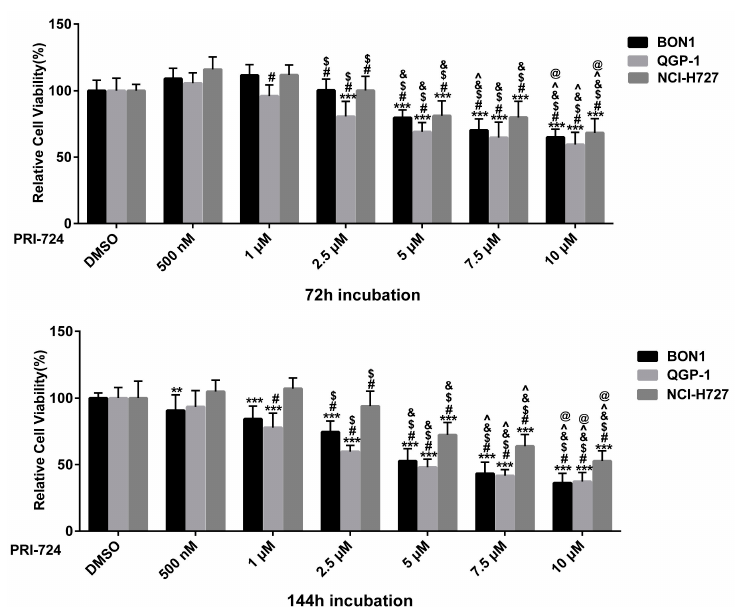
Figure 6. Effect of PRI-724 on the reduction of NET cell viability in a dose- and time-dependent manner. The cell viability of human pancreatic BON1 and QGP-1and bronchial NCI-H727 NET cell lines was assessed after treatment with PRI-724 compared with that of DMSO control. The data are expressed as mean ± SD. Each experiment, with technical triplicates, was repeated at least thrice. * p < 0.05, ** p < 0.01, and *** p < 0.001 compared with that of DMSO controls. # p < 0.05(1 µM–10 µM vs 500 nM respectively), $ p < 0.05(2.5 µM–10 µM vs 1 µM respectively), & p < 0.05 (5 µM–10 µM vs. 2.5 µM respectively), ^ p < 0.05 (7.5 µM–10 µM vs 5 µM, respectively), @ p < 0.05 (7.5 µM vs. 10 µM).